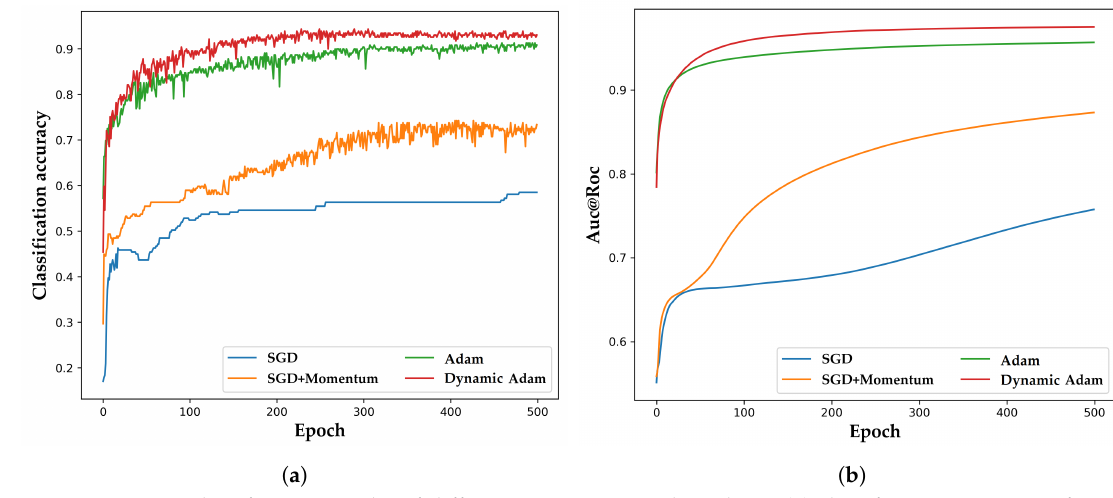
Figure 10. Classification results of different optimization algorithms: ( a ) classification accuracy of different optimization algorithms; and ( b ) Auc@Roc of different optimization